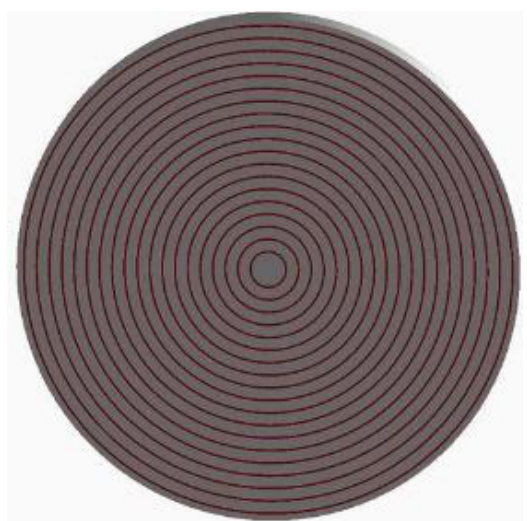
Figure 2. Physical model of silicon drift detector (SDD) using Geant4.